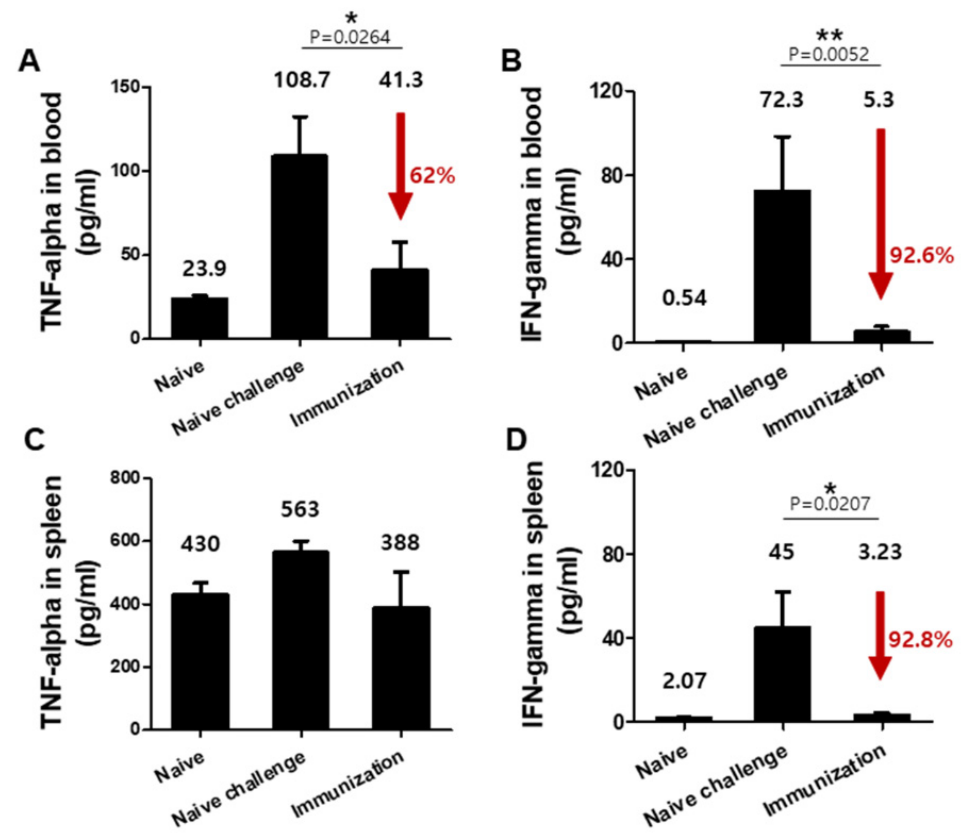
Figure 5. Pro-inflammatory cytokines (TNF- α and IFN- γ ) response. To determine the levels of inflammatory cytokines TNF- α ( A , C ) and IFN- γ ( B , D ) upon challenge infection, mouse blood ( n = 6) and spleen ( n = 6) was collected at 7 dpi. Higher levels of TNF- α ( A ), * P < 0.05 and IFN- γ ( B ), ** P < 0.01 in the blood and IFN- γ ( D ), * P < 0.05 in the spleen were detected in the non-immunized control (Naïve Challenge) compared to VLPs immunized mice (Immunization). 3.5. VLPs Vaccination Led to Significantly Reduced Parasitemia, Delayed Bodyweight Loss, and Prolonged Survival Blood samples were drawn from all groups of mice after P. berghei infection to eval- uate the parasitic burden in mice (Figure 6A). At 28 days post-challenge infection, mice showed significant reductions in parasitemia were observed from the blood of vacci- nated mice (680 parasites) compared to those of unimmunized controls (5800 parasites, ** P < 0.01). Mice immunized with VLPs maintained their normal weight for 48 days, while the non-immunized mice control began to experience reduced body weight from day 4 post-challenge infection (Figure 6B). Immunized mice survived much longer than non-immunized control mice (Figure 6C). These results indicated that VLP immunization contributed to significant reductions in parasitemia level, body weight loss and